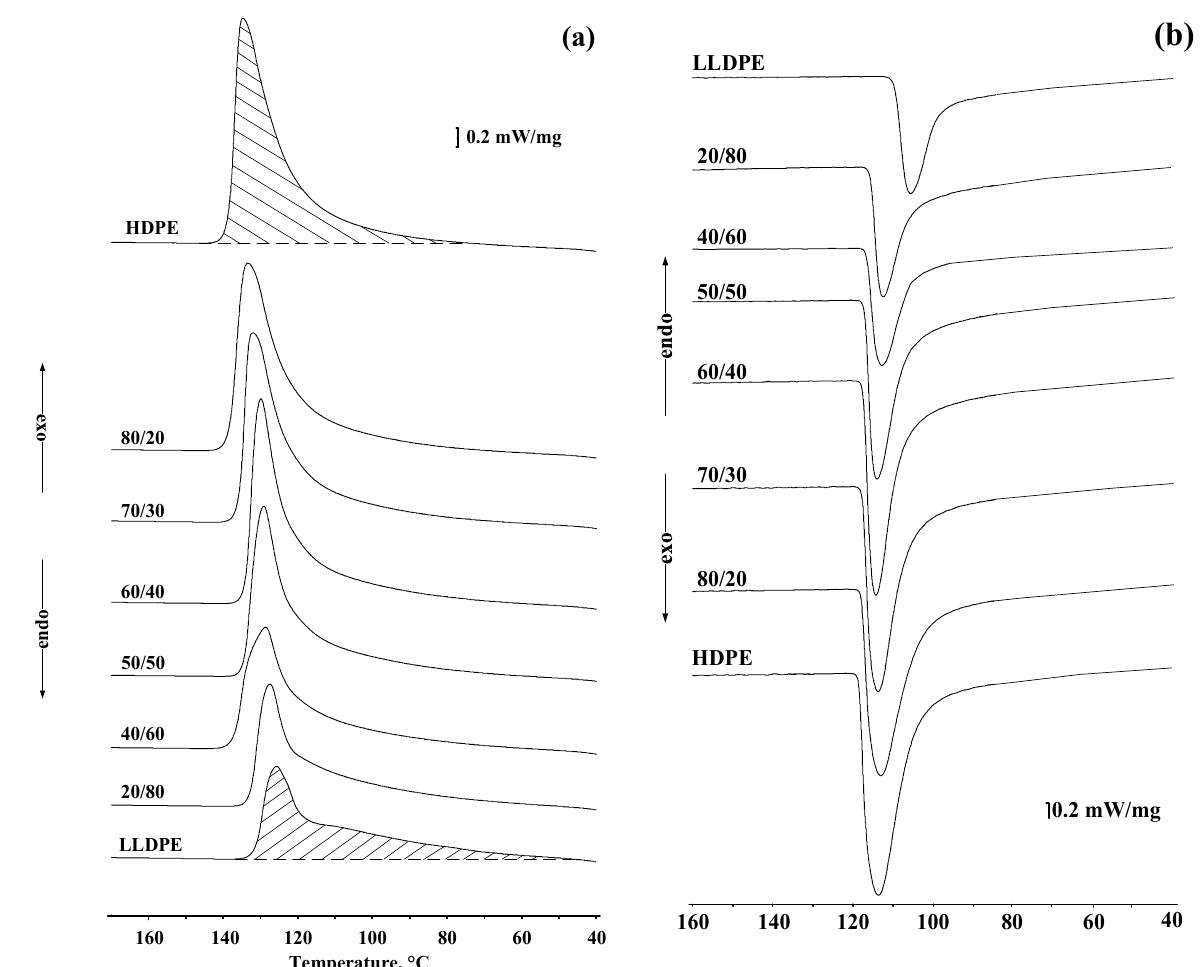
Figure 1. ( a , b ) Effect of LLDPE on the differential scanning calorimetry (DSC) curves of HDPE/LLDPE compositions. The plotted dependence of the melting heat and the crystallization heat on the LLDPE content in the compositions is linear (Figure 2a). As can be seen from Figure 2b and Table 3, the melting heats and degree of crystallinity of the mixtures also change linearly with changes in the compositions and the content of the co-monomers (butene-1 and hexene-1 side branches) in the linear structure of the HDPE-1/LLDPE mixtures.